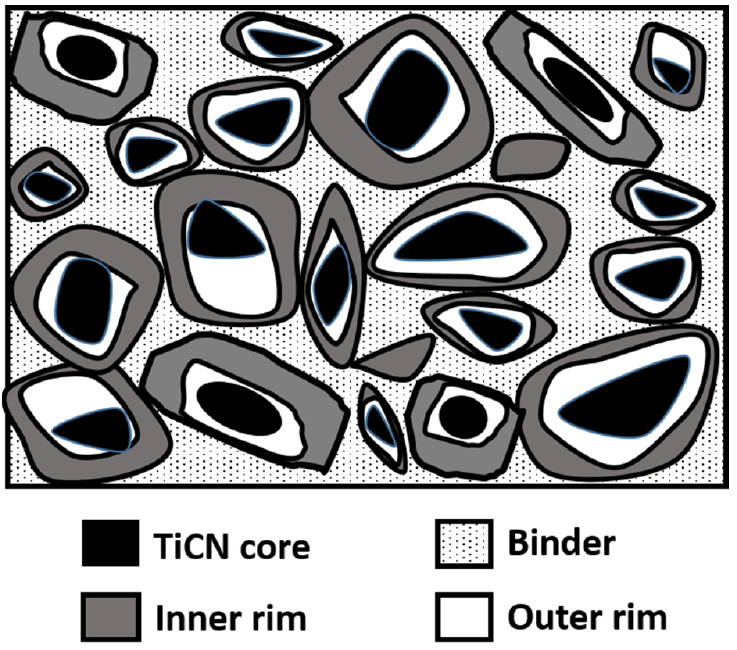
Figure 5. Schematic of a commercial cermet microstructure imaged using SEM. The core-rim structure of the TiCN-based cermet depends on the various constituents, which include C, N, secondary carbides, other additives, and binder metals (Ni, Co, Mo, etc.). In TiCN-based cermets, the binder phase is mostly composed of either Ni or Co. The solid solution hardening of this binder phase has a critical role in cermet applications. In the TiCNNi-Mo system, additional Ni metal content improves bending strength and causes a reduction in hardness [143,144]. The addition of Co into the TiCN-based cermets results in improved toughness and oxidation resistance due to the higher toughness of Co compared to Ni and the better wettability of Co in the hard phase in the cermet. However, the TiCN- based cermets with Co have inferior corrosion resistance compared to those with Ni. Mo has a much larger atomic radius compared to Ni; adding Mo into TiCN-based cermets will reduce the solid solubility of Ti in Ni, hence promoting a stable carbonitride [145]. The rim of a TiCN cermet rich with Mo can suppress the recrystallization by holding up the TiCN grain growth [146]. This will, in effect, improve the relative density, resistance to plastic deformation, and strength of cermets [147,148]. The Mo content in the cermets should be optimum, or else it will lead to a steep decrease in the fracture toughness and